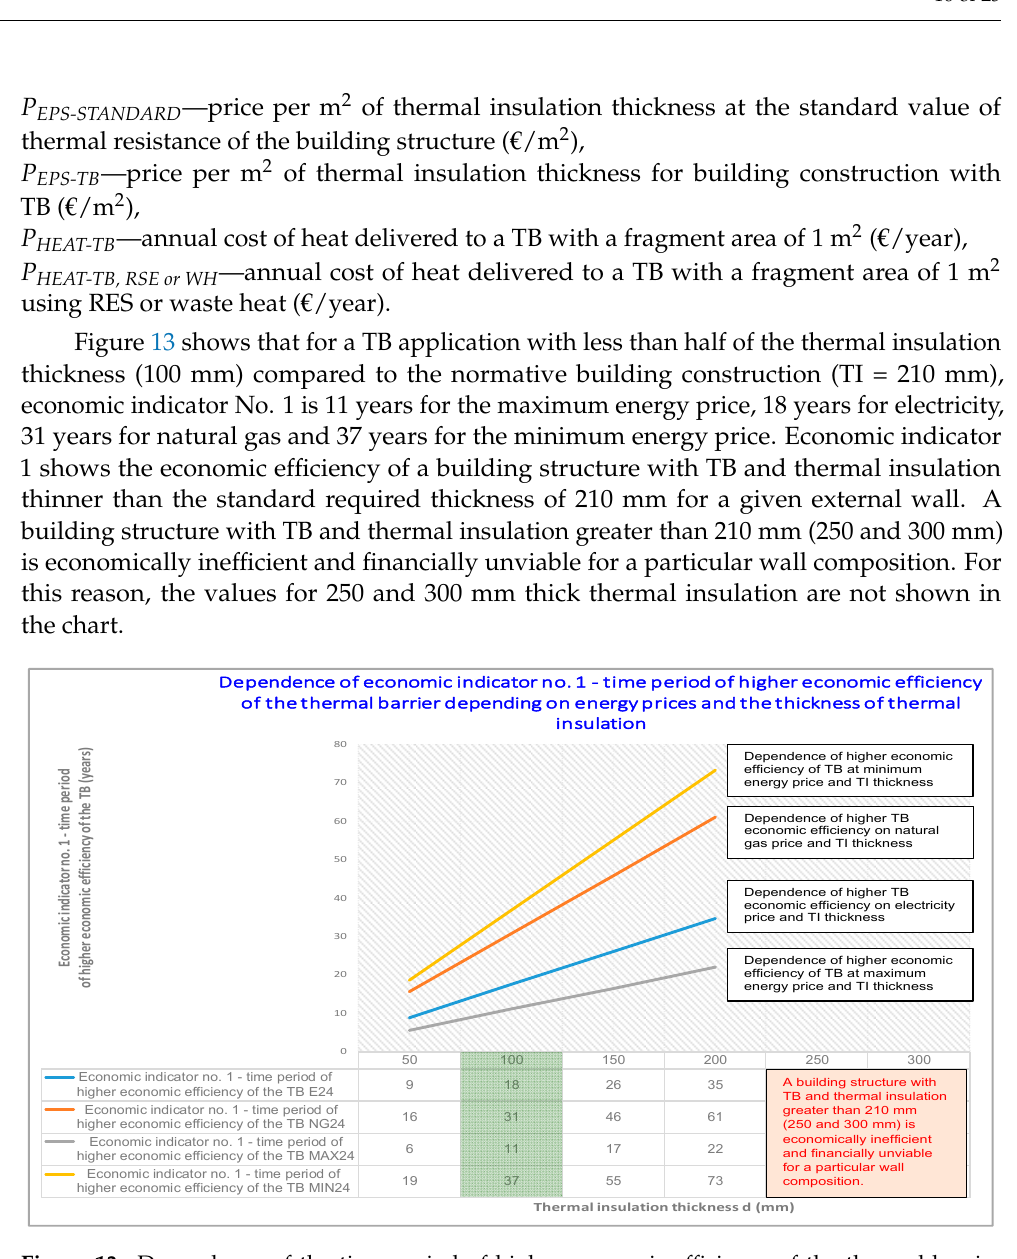
Figure 13. Dependence of the time period of higher economic efficiency of the thermal barrier depending on energy prices and the thickness of thermal insulation (year).